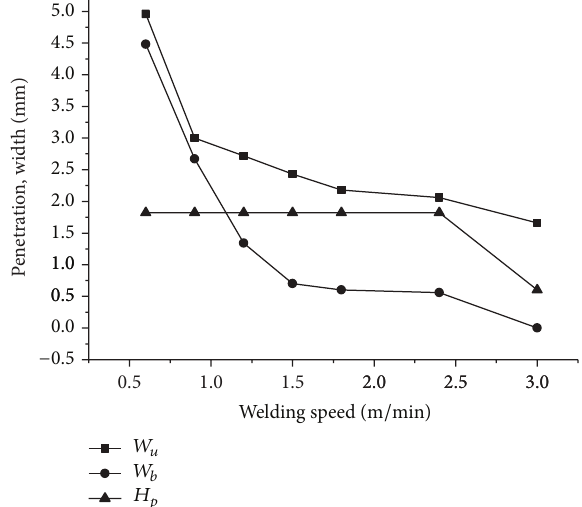
Figure 4: Influence of welding speed on width and penetration of welded seam. ( Δ𝑍 = 0 mm; 𝑃 = 1.5 kW; 𝑈 𝑓 = 15